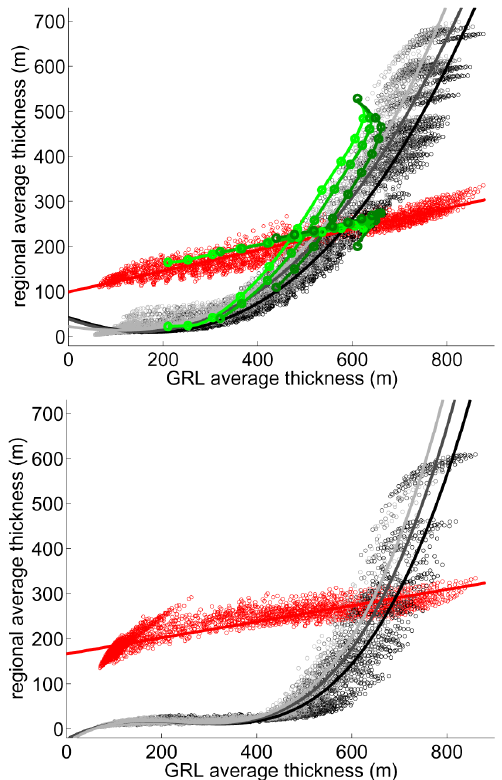
Fig. 9. Simulated average ice thickness in northeastern (gray, black) and and southern (red) regions, as a function of the average ice thickness of the entire ice sheet, for 126ka in IPSL CM4 (top panel) and 130ka in CCSM3 (bottom panel). Each data point cor- responds to one of 15552 ensemble members with a different set of parameters, run for 10000yr. Different ice initial temperatures are highlighted for northeastern Greenland in light gray ( − 30 ◦ C), gray ( − 40 ◦ C) and black ( − 50 ◦ C). Polynomial fits of first and third order are included for visibility. The transient evolution of the sim- ulation of Fig. 5 is shown in green with circles spaced every 1000yr and ice initial temperature represented in color brightness as before. Ice thickness in northeastern Greenland responds rapidly to a reduc- tion in total ice thickness, while ice in southern Greenland is more